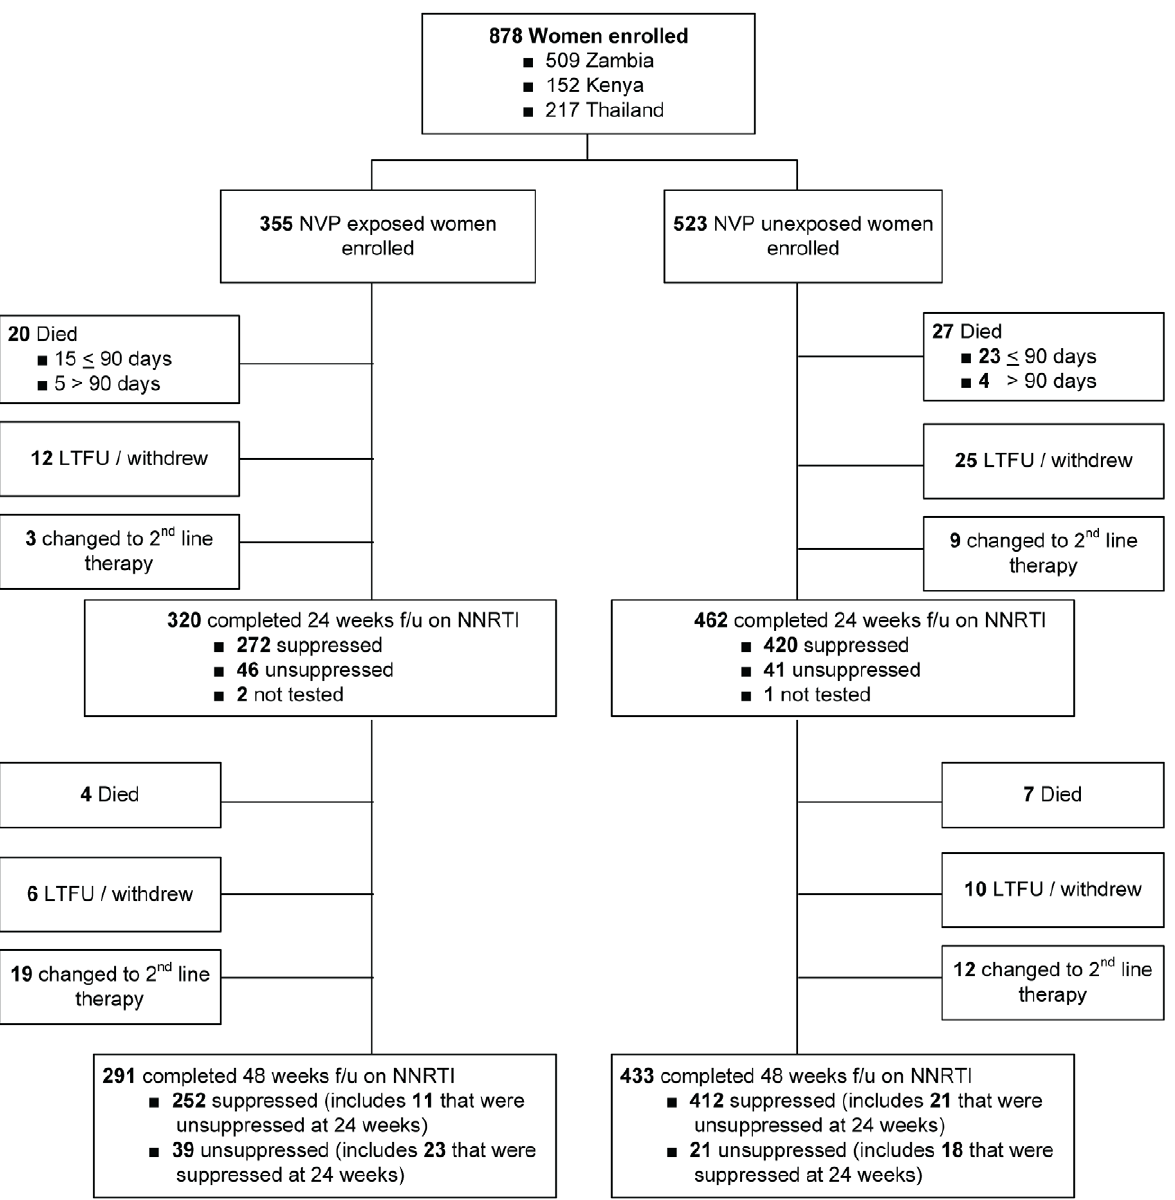
Figure 2. Study Schema for the NNRTI Response Study—Zambia, Kenya, Thailand (2005–2008). Among the 779 women who completed 24 wk follow-up on NNRTI-based ART (excluding the three women who were temporarily off therapy), self-reported adherence over the five visits by week 24 was greater than 95% for 440 (95%) of 461 NVP-unexposed women and 300 (94%) of 318 NVP-exposed women ( p =0.5). Among the 724 women who completed 48 weeks on NNRTI-based ART, self-reported adherence over the two visits at weeks 36 and 48 was greater than 95% for 419 (97%) of 433 NVP-unexposed women and 280 (96%) of 291 NVP-exposed women ( p =0.7). f/u, follow-up; LTFU, lost to follow-up.